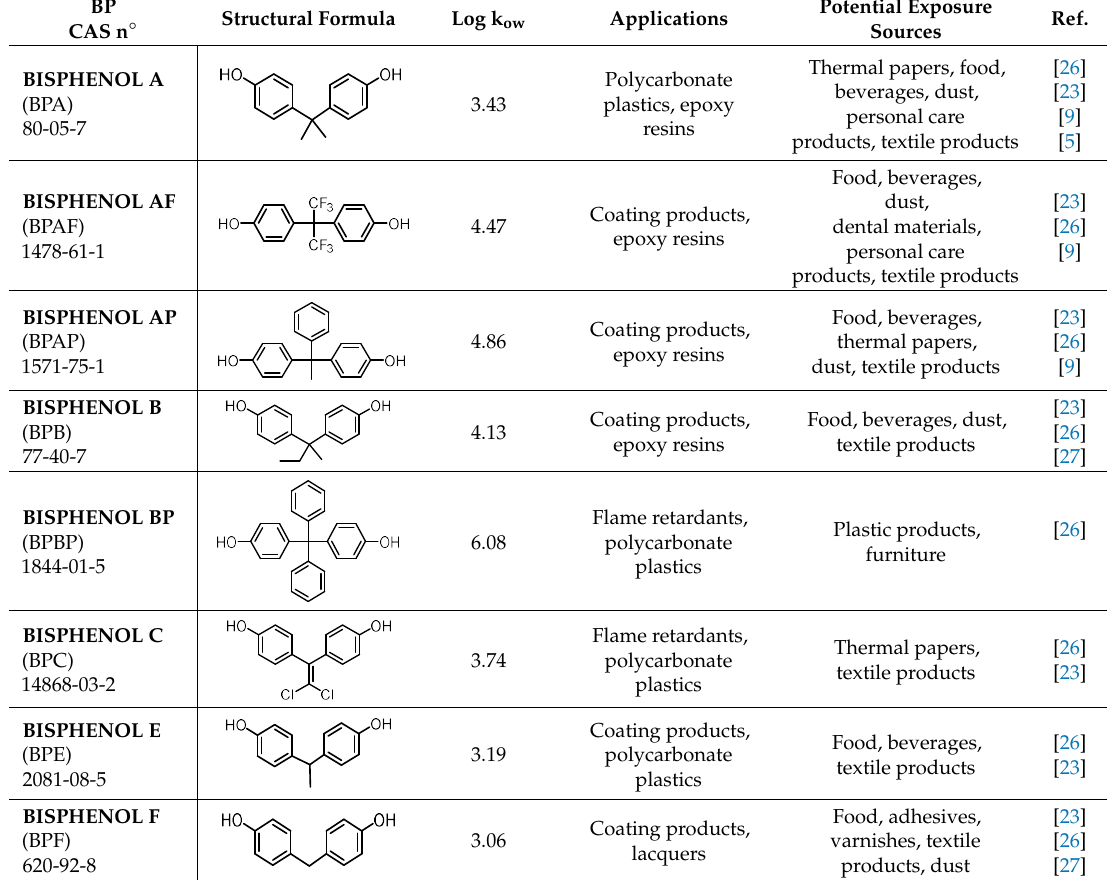
Table 1. Structures and physicochemical properties of the bisphenols (BPs) investigated. BP Structural Formula Log k ow Applications CAS n ◦